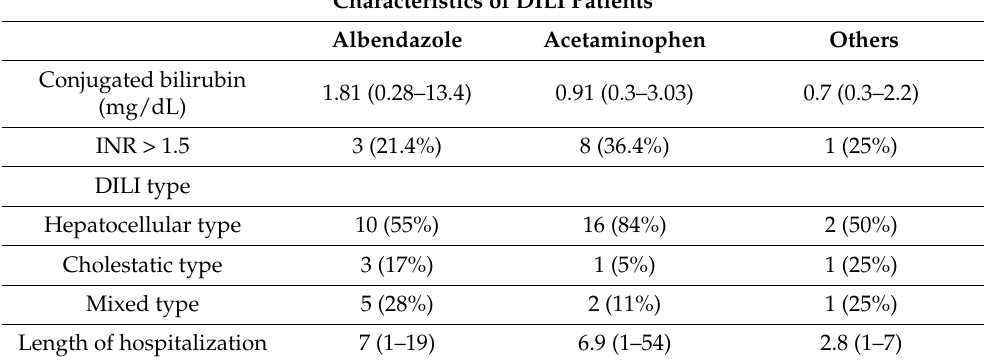
Characteristics of DILI